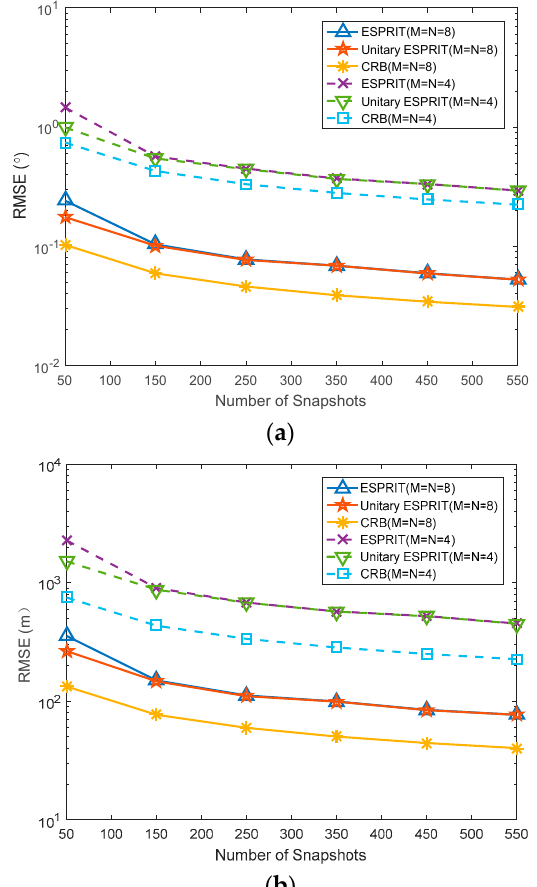
Figure 6. Estimation of target parameters by the proposed algorithm and ESPRIT algorithm with di ff erent SNR. ( a ) RMSE of DOA versus SNR; ( b ) RMSE of range versus SNR.